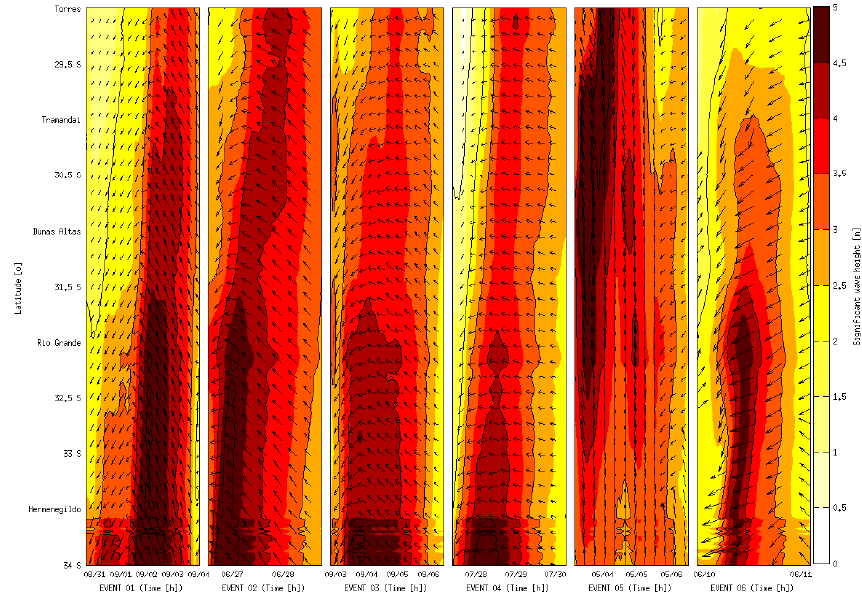
Figure 5. Hovmöller diagram for deep water waves. The diagram displays the wave parameters ( H s and D p ) for 50m isobathymetry. The Fig. 5. Hovm¨oller diagram for deep water waves. The diagram display the wave parameters ( H s and D p ) for 50 m isobathymetry. The latitudeofthewaveisdisplayedalongthey-axis,andthetimeisalongthex-axis.The H s areinacolorscaleandthe D p asvectors. latitude of the wave is displayed along the y axis, and the time is shown along the x axis. The H s are on a color scale and the D p are shown as vectors.